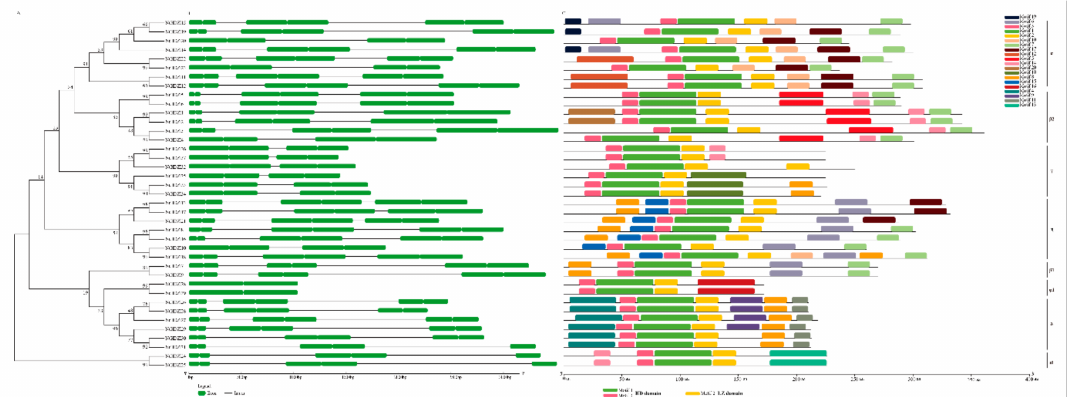
Figure 2. Gene structure, motif prediction of NtHD-Zip I proteins in N. tabacum . ( A ) The phylogenetic tree is constructed using the full-length amino acid sequences from N. tabacum alone by the NJ method. ( B ) Intron / exon structure of NtHDZI genes. Introns and exons are represented by black lines and green boxes, respectively. ( C ) Conserved motifs distribution of NtHDZI proteins. All motif predictions are obtained through the MEME online website (http: // meme.nbcr.net / meme / cgibin / meme.cgi). Di ff erent color boxes at the top right-hand corner represent di ff erent motifs detected. The characteristic motifs, motif 1 and motif 3, corresponding to HD domain and motif 2 corresponding to LZ domain, are highlighted at the